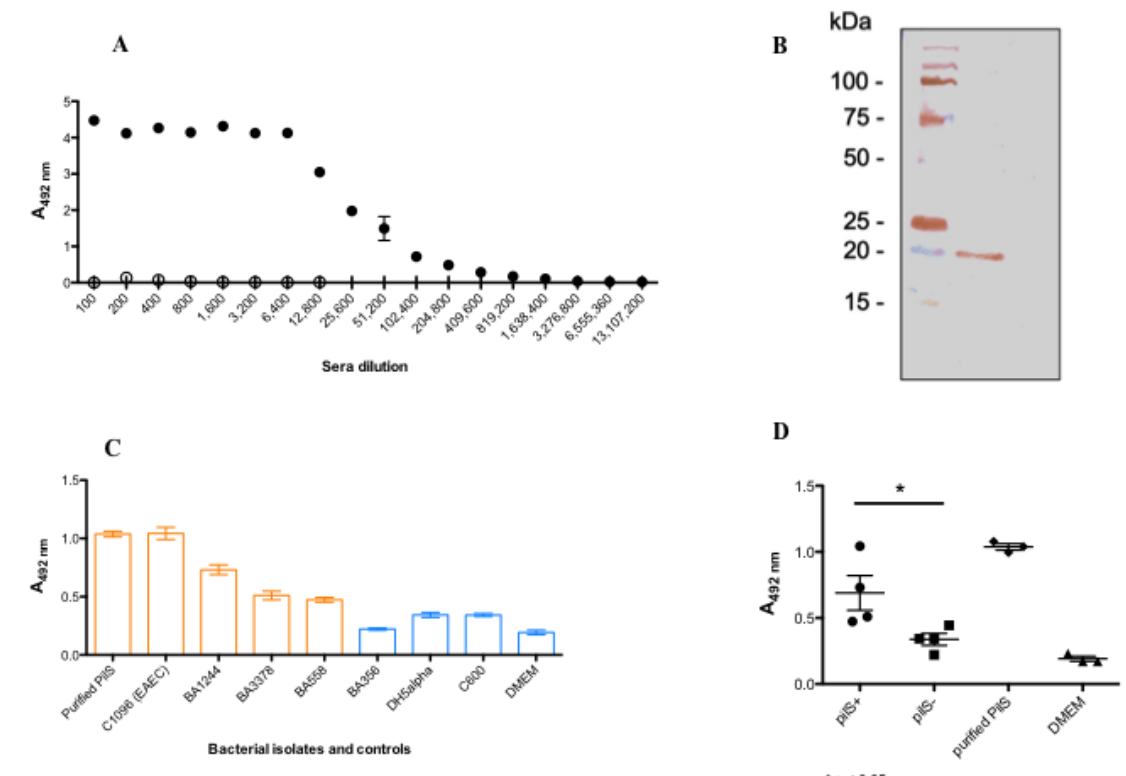
Figure 8. ELISA and immunoblotting of mice anti-rPilS serum for detection of PilS. ( A ) Mice pre immune (empty dot) and anti-rPilS (black dot) sera; ( B ) Nitrocellulose membrane containing protein fractions of rPilS were incubated with 1:100 dilution of PilS antiserum followed by peroxidase goat anti-rabbit IgG (1:5000); the reaction was revealed with DAB + H 2 O 2 . Precision Plus Protein Standards (Kaleidoscope # 1610375, Bio-Rad) ( C ) ELISA for PilS detection in bacteria cells: aEPEC BA1244, BA3378, BA558 and aEAEC (C1096) strains (orange bars). BA356, E. coli DH5 α and E. coli C600 were employed as pilS - strains (blue bars). Purified rPilS protein (orange bar) and DMEM